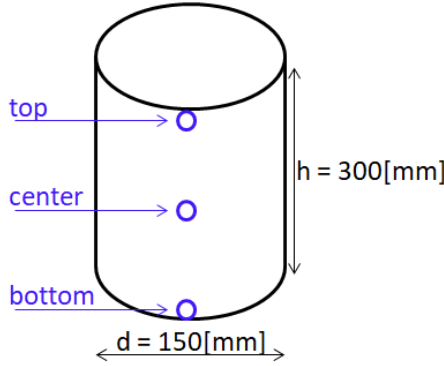
Figure 7. Distribution of laboratory test sites for samples in scheme A.